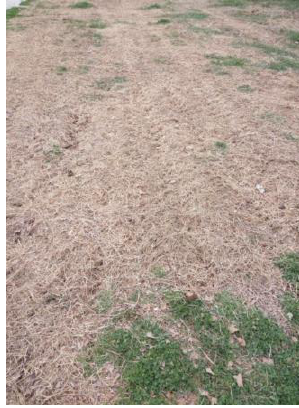
Figure 5. Relationship between travel reduction and coefficient of gross traction of road surface.